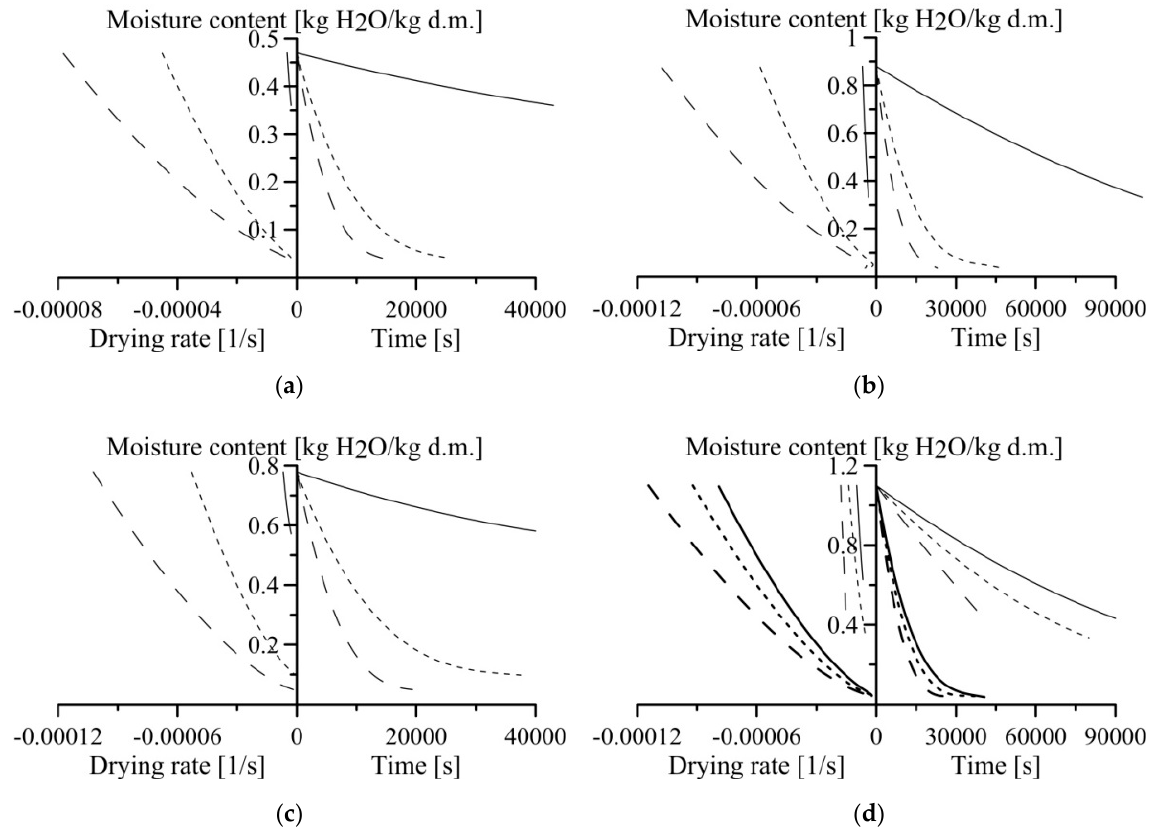
Figure 1. Moisture content versus time and drying rate versus moisture content for drying of ( a ) spruce, ( b ) beech, ( c ) willow sawdust at 0.01 m/s and at air temperatures; (——) 25 ◦ C, (- - -) 60 ◦ C, (— —) 80 ◦ C, and alder ( d ) sawdust at different air temperatures and velocities; (——) 25 ◦ C, 0.01 m/s, (- - -) 25 ◦ C, 0.15 m/s, (— —) 25 ◦ C, 1.5 m/s, (——) 60 ◦ C, 0.01 m/s, (- - -) 60 ◦ C, 0.15 m/s, (— —) 60 ◦ C, 1.5